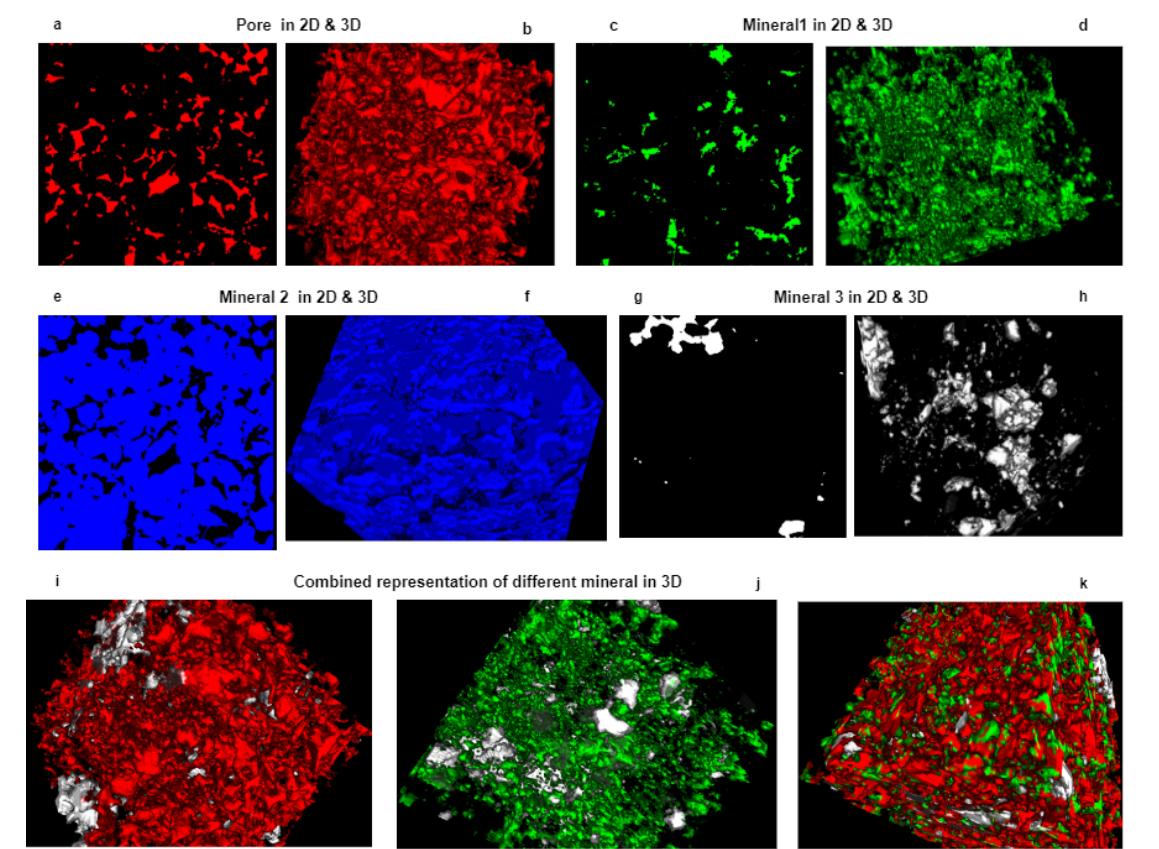
Figure 4. Representation of each particle individually. We have leveraged the free image analysis software Zen lite to represent our individual particle as multichannel data. ( a , b ) The red area represents the pore area of the sample for both 2D and 3D. ( c , d ) The lime area represents the mineral 1 area of the sample for both 2D and 3D. ( e , f ) The blue area represents the mineral 2 area of the sample for both 2D and 3D. ( g , h ) The white area represents the mineral 3 area of the sample for both 2D and 3D. ( i – k ) Three-dimensional (3D) representation of combined